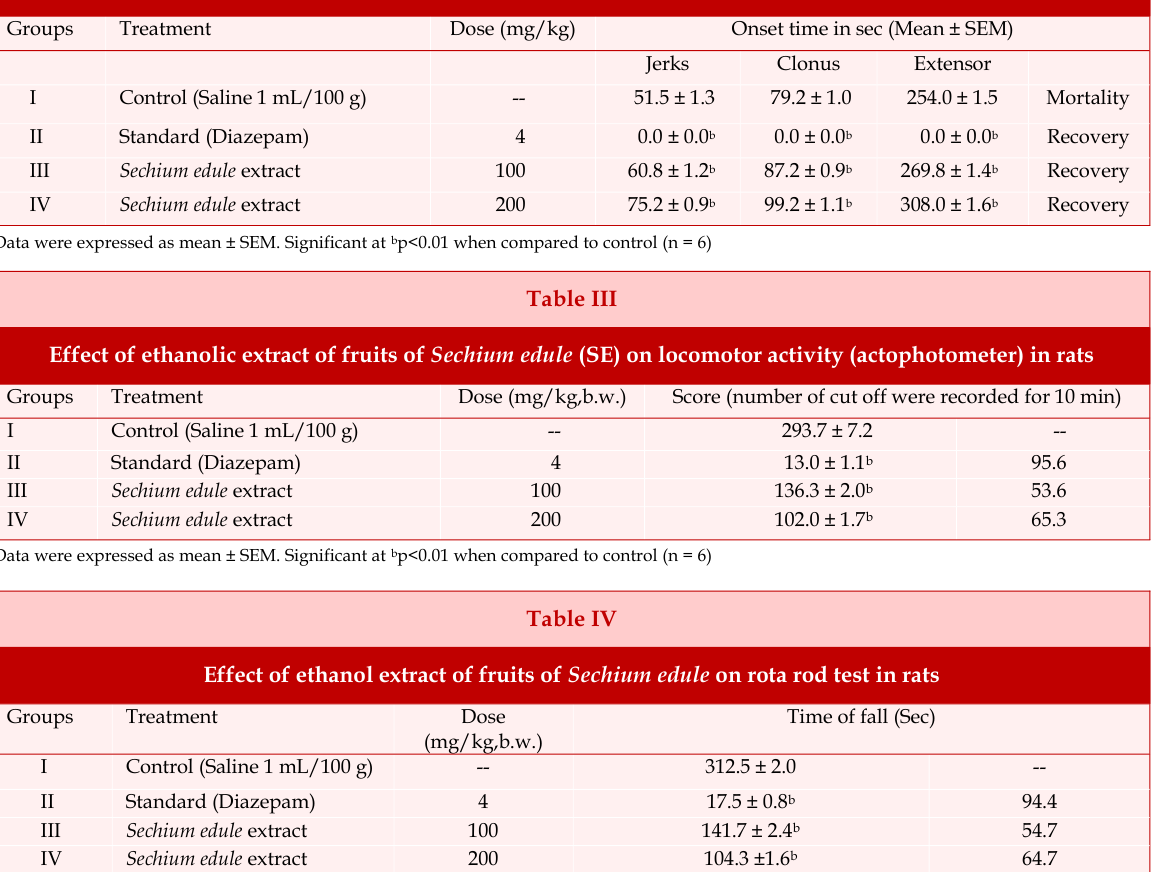
Effect of ethanol extract of fruits of Sechium edule against PTZ Induced convulsions in rats Groups